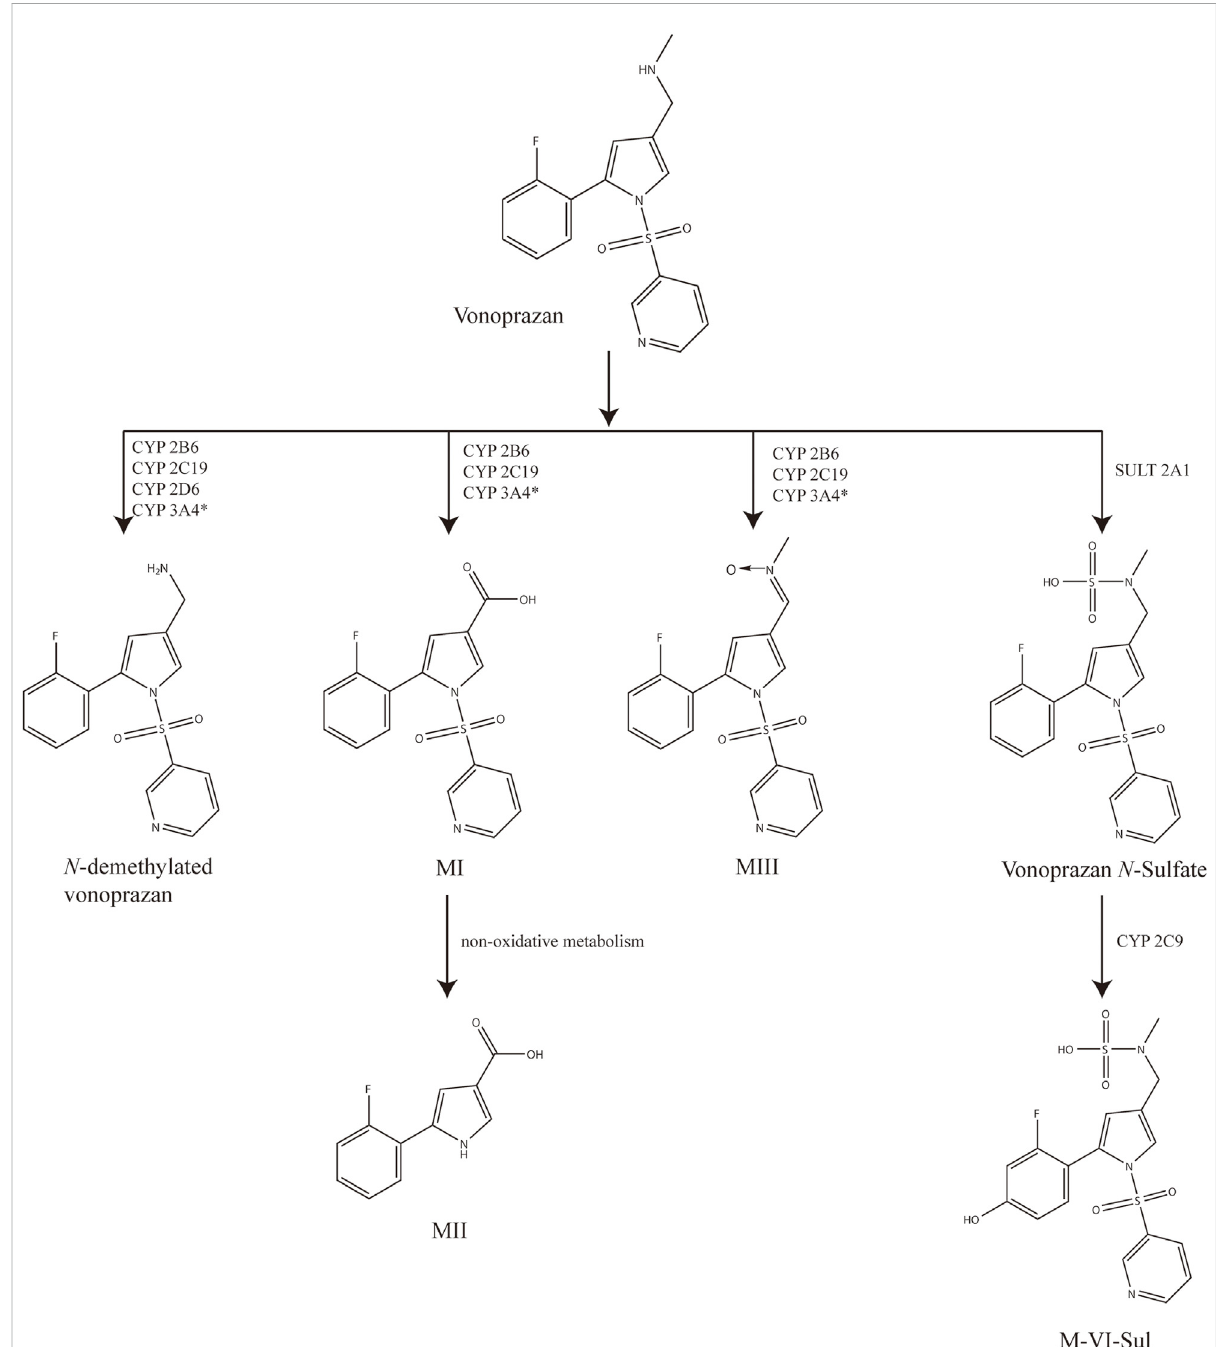
FIGURE 1 Postulated metabolic pathways of